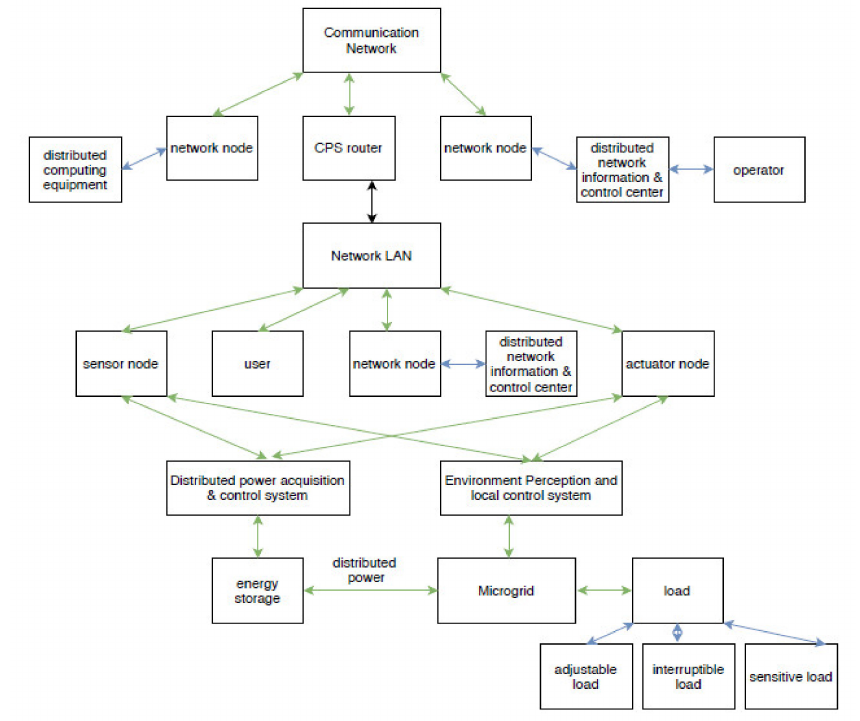
Figure 5. Interactive environment of a microgrid communication